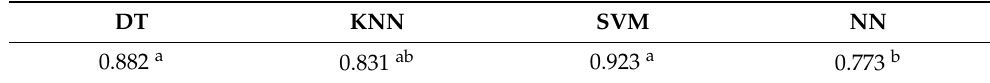
Table 8. Results of Tukey’s test analysis.